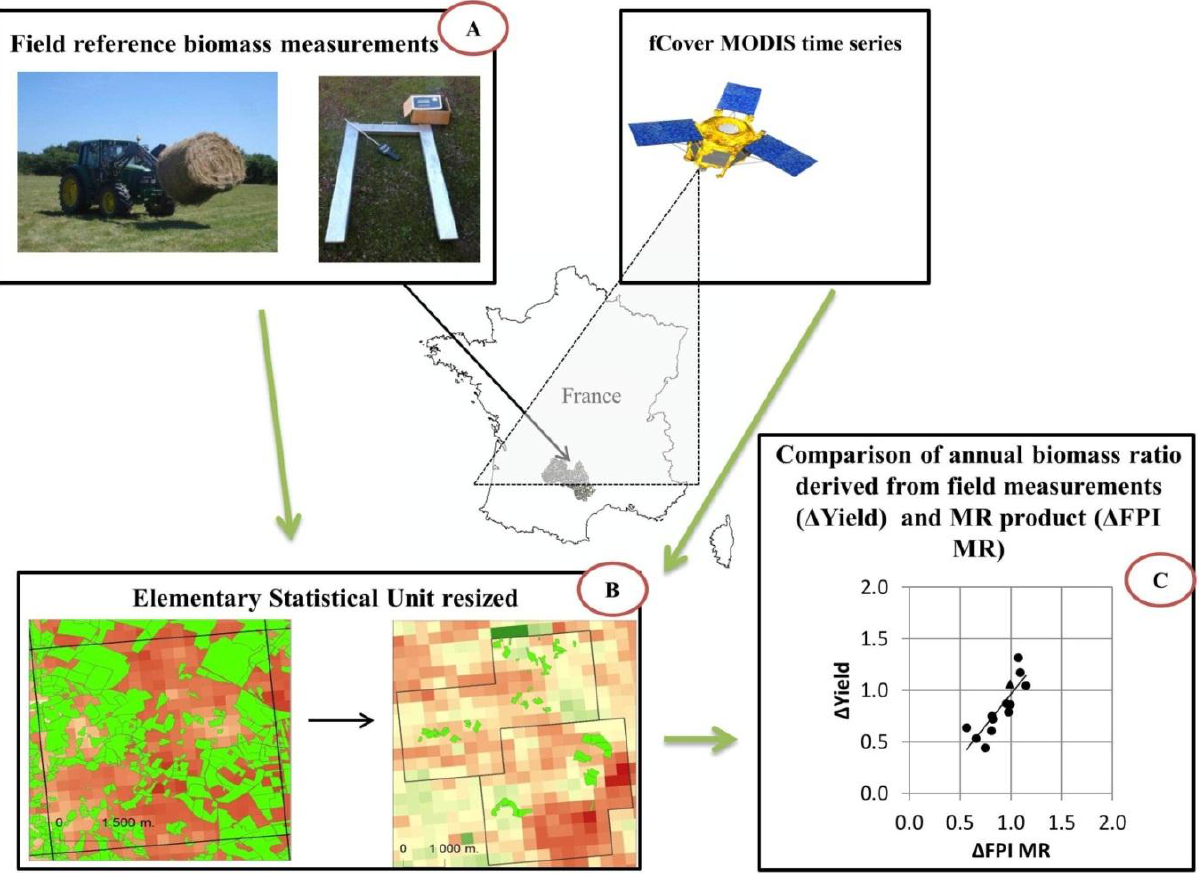
Figure 4. Workflow of the direct comparison methodology. fCover = fraction of green vegetation cover; MODIS = Moderate Resolution Imaging Spectroradiometer; MR = Moderate Resolution; FPI = Forage Production